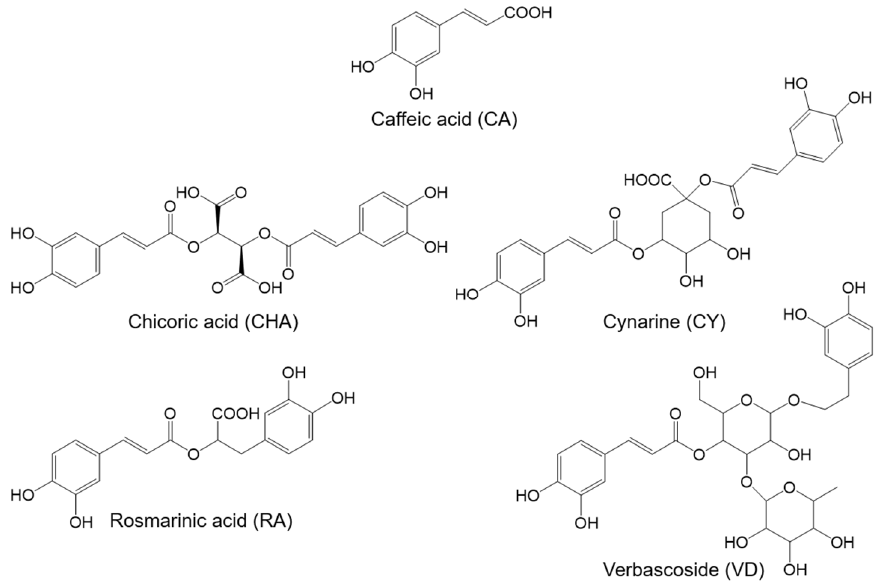
Figure 1. Structures of the added phenolic acid derivatives.